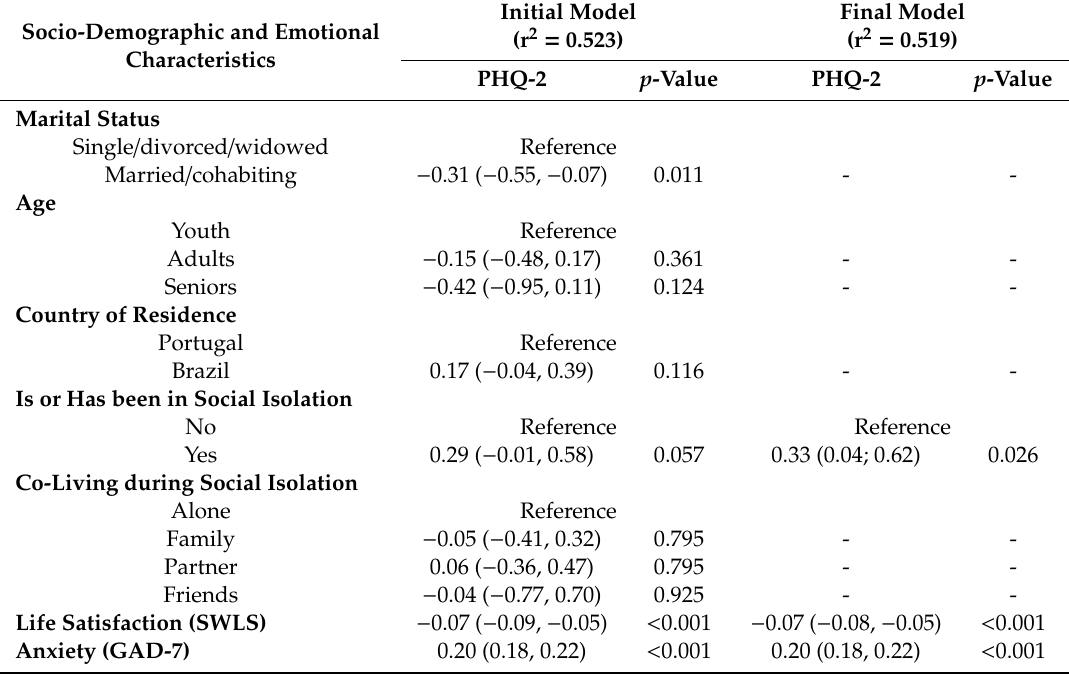
Table 5. Regression coe ffi cients for Patient Health Questionnaire-2 (PHQ-2) as an outcome with socio-demographic and emotional variables as predictors, from univariate multiple linear